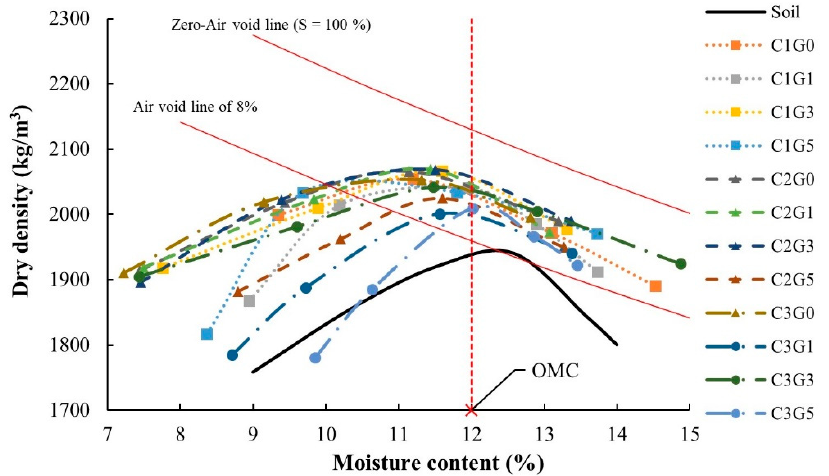
Figure 9. Compaction test results of all samples. Note : Soil refers to the substandard lateritic soil used as a benchmark.